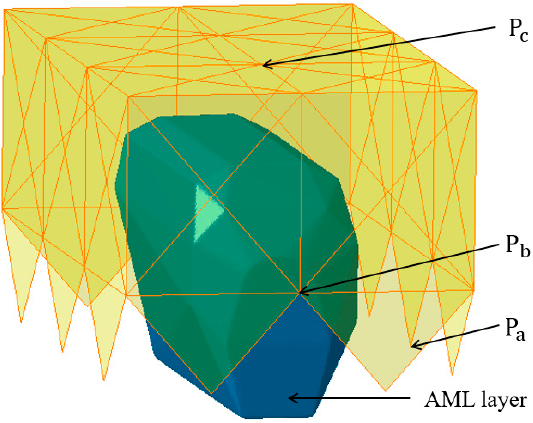
Figure 10. Positions of three sound field points.